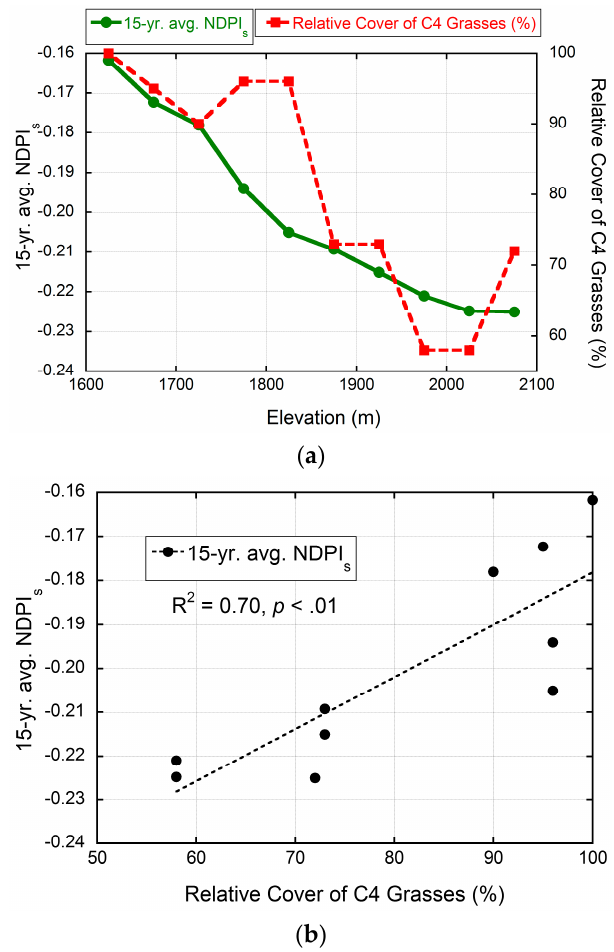
Figure 14. Comparison of the 15-year average NDPI s and field-based estimates of the relative surface cover of C 4 grasses, both sampled from the northeastern side of the Huachuca Mountains in the southeastern part of the study area (Figures 2 and 11), and displayed ( a ) as a function of elevation, and ( b ) as a scatter plot with results from least-squares linear regression. Both data sets represent average values for 50-m elevation intervals. The NDPI s data are from the rectangular area bounded by the dotted line in Figure 11, whereas the relative cover data are from field plots studied by Wentworth [85].